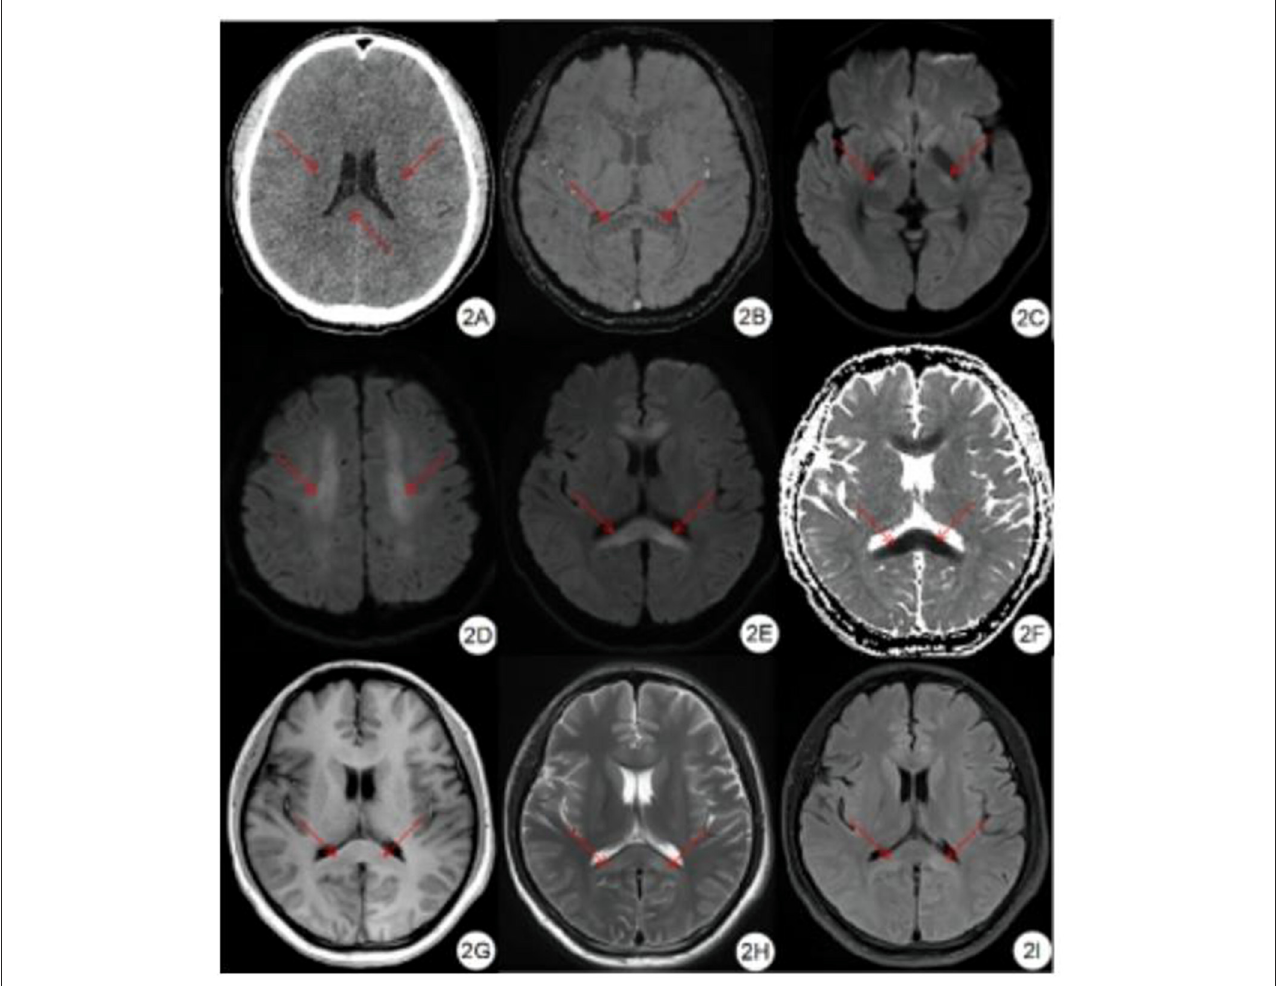
FIGURE2 Severe HACE patient. (A) CT plain scan showed decreased density of bilateral corona radiata and corpus callosum, and shallow sulci and fission. (B) SWI showed symmetrical diffuse speckled hypointensity in the brain parenchyma, especially in the splenium and genu of the corpus callosum. (C–E) DWI showed symmetrical hyperintensity in bilateral corticospinal tract, centrum semiovale, splenium and genu of the corpus callosum. (F) ADC showed symmetrical hypointensity in the splenium and genu of the corpus callosum. (G) T1WI showed symmetrical hypointensity in the splenium and genu of the corpus callosum. (H) T2WI showed symmetrical hyperintensity in the splenium and genu of the corpus callosum. (I) FLAIR showed symmetrical hyperintensity in the splenium and genu of the corpus callosum.